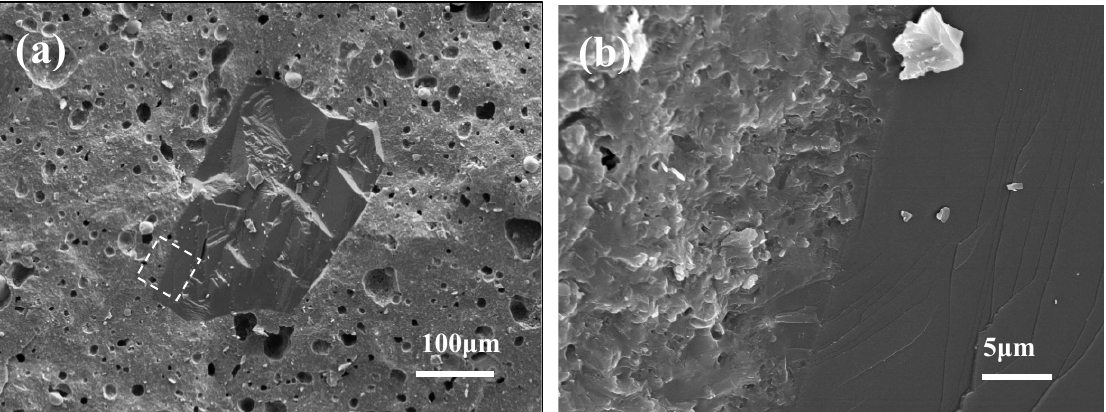
Figure 12. Microstructure of the TC2/CBN composite after flexural strength testing, ( a ) low magnification and ( b ) high magnification.